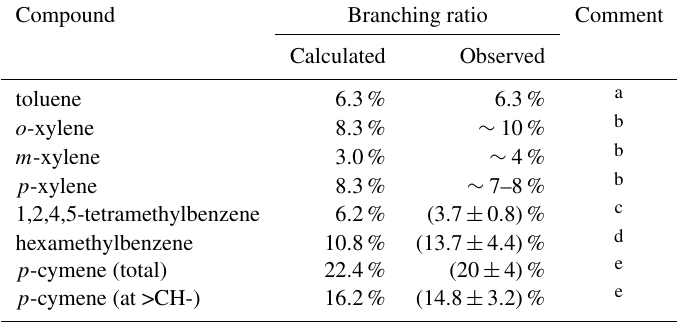
Table 4. Comparison of estimated and reported branching ratios for H-atom abstraction, k abs /(k abs + k add ) , at 298K except where indicated. Compound Branching ratio Comment